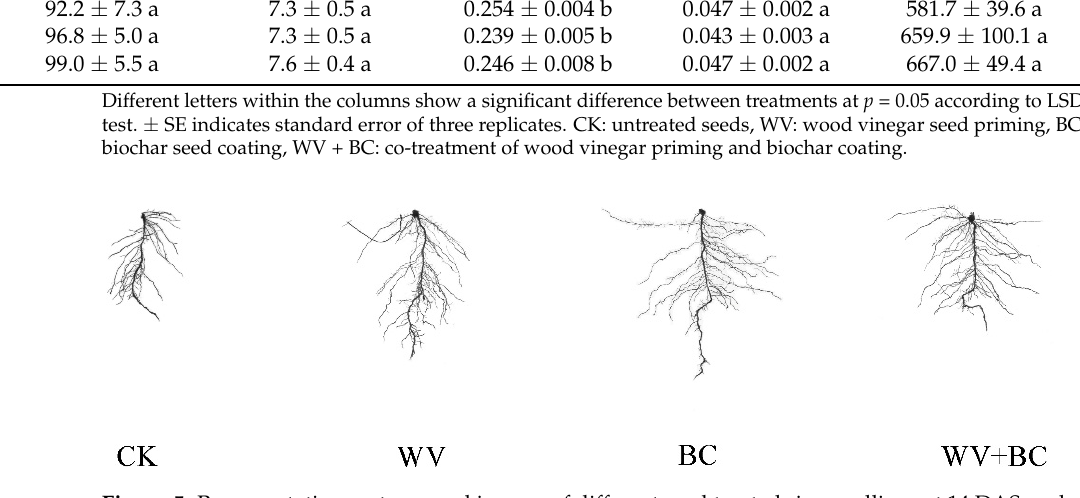
Figure 5. Representative root scanned images of different seed treated rice seedlings at 14 DAS un- der growth chamber experiment. CK: untreated seeds, WV: wood vinegar seed priming, BC: biochar seed coating, WV + BC: co-treatment of wood vinegar priming and biochar coating.